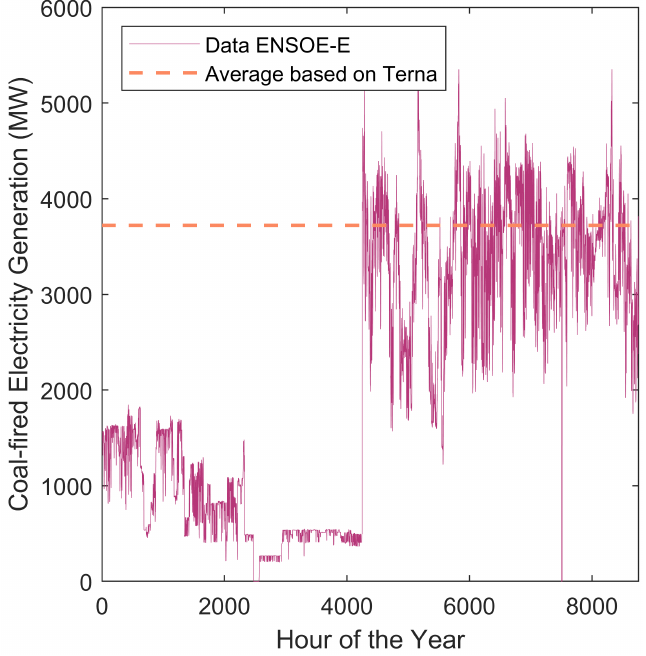
Figure A1. Reported coal generation in Italy in 2017 in [55] and the average coal-based electricity generation reported by [60].